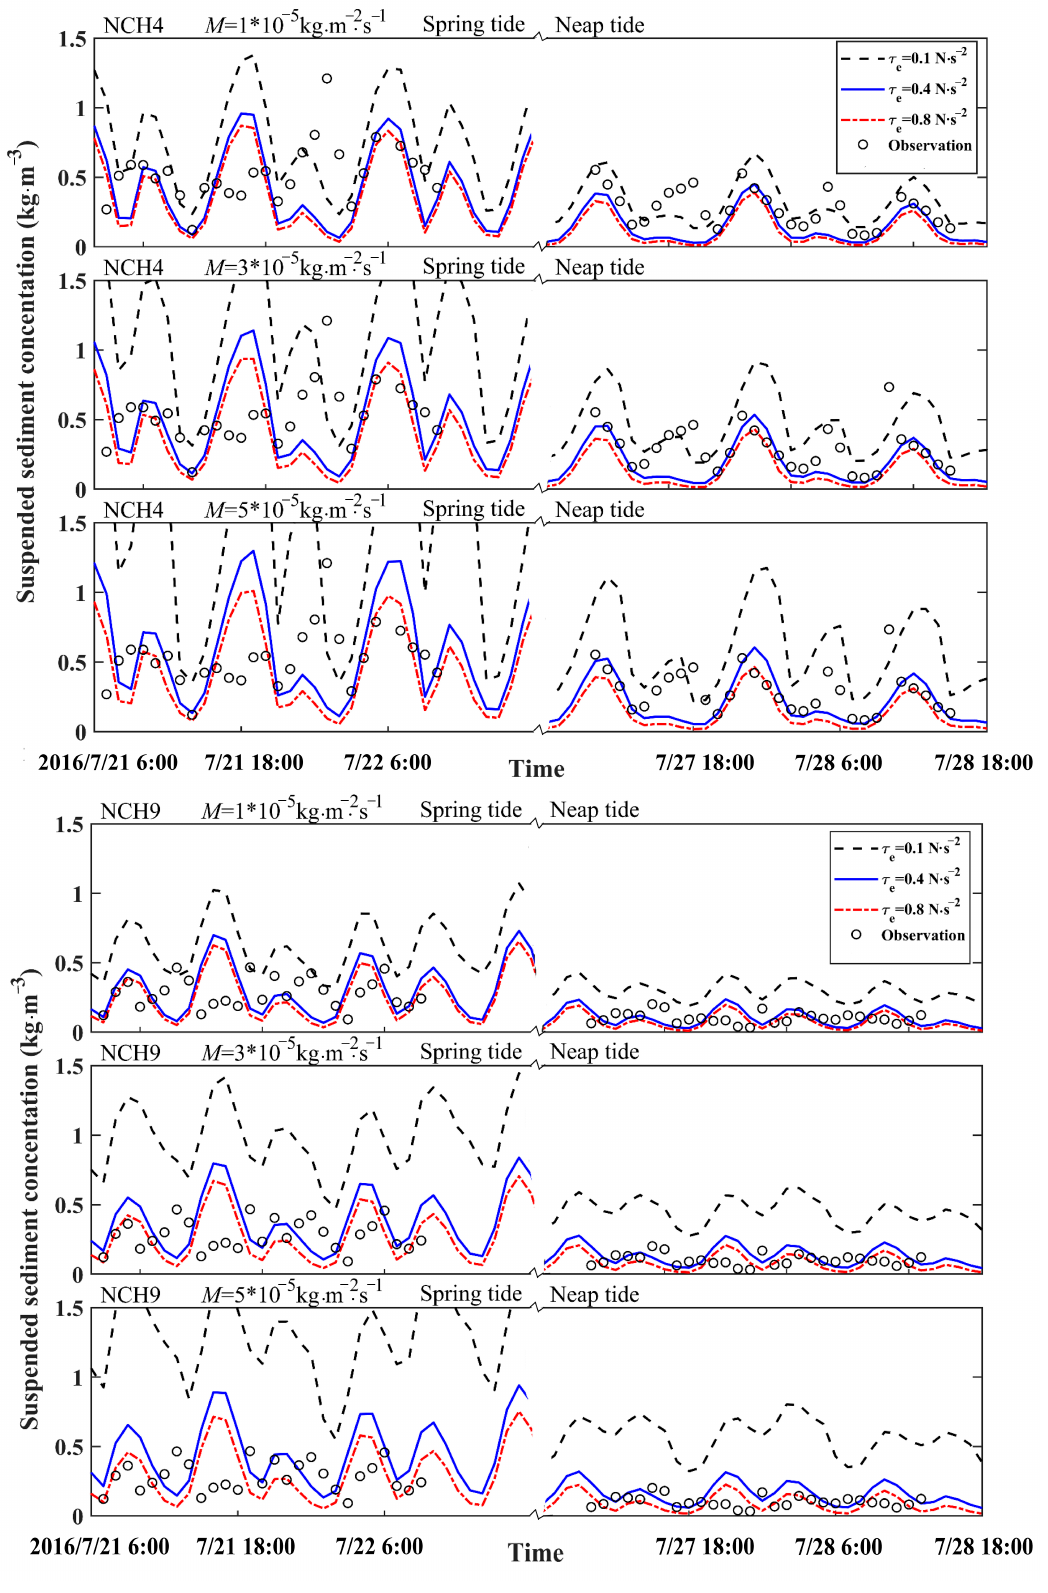
Figure 9. Comparison of simulated and measured SSC under the different critical shear stresses and erosion coefficients at 8 stations shown in Figure 3b. The graphs on the left and right sides of break-line symbol show the variation of SSC during spring tide and neap tide,